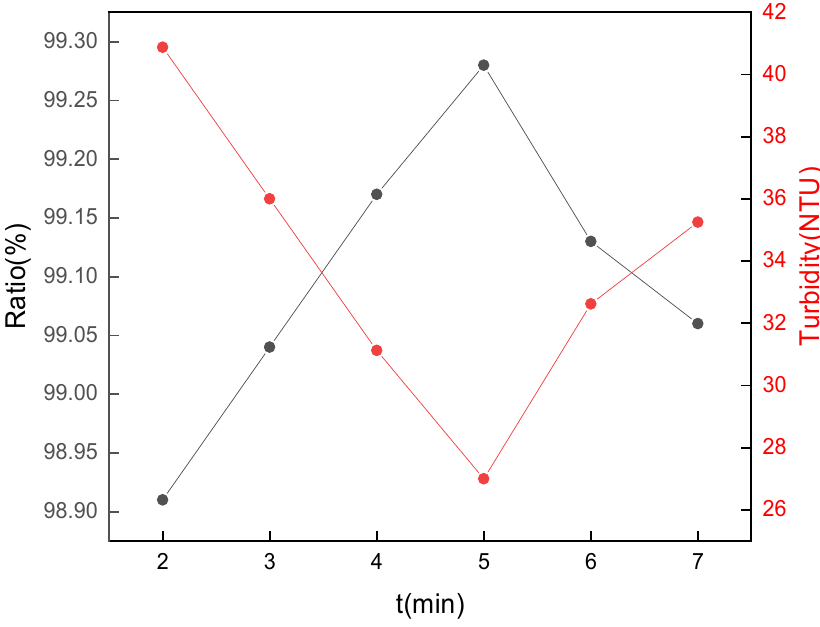
Figure 9. Effect of radiation time on the turbidity removal ratio.